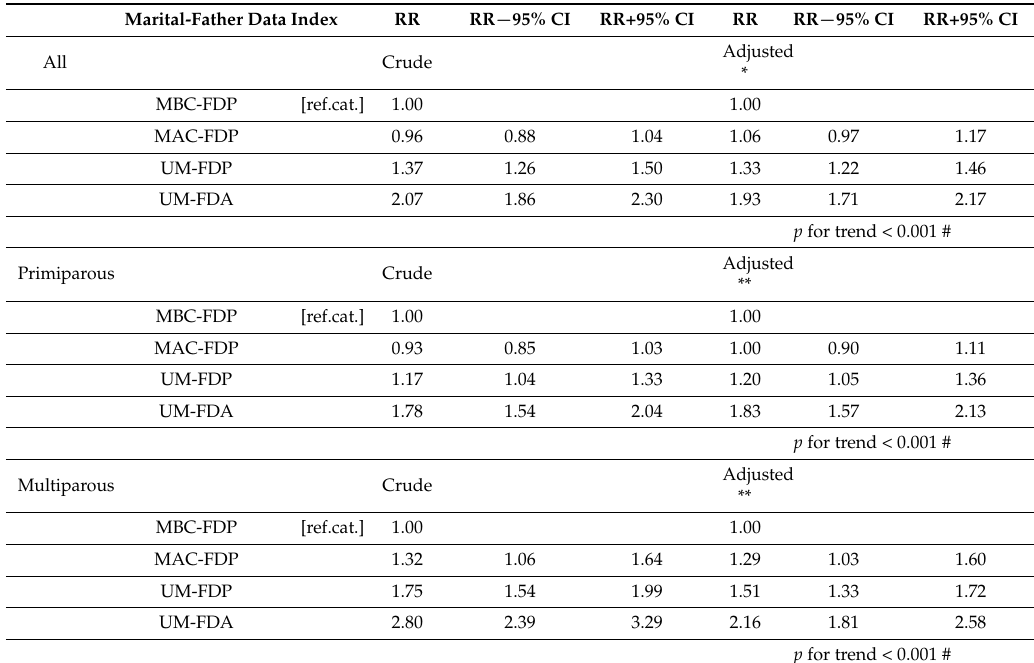
Table 4. The association between the Marital-Father Data index (as a proxy of maternal psychosocial stress) and preterm birth (PTB) before and after stratification for parity, tested by simple and multiple Poisson regression analyses. Crude and adjusted risk ratios (RR) with 95% confidence intervals (CI) for PTB by categories of